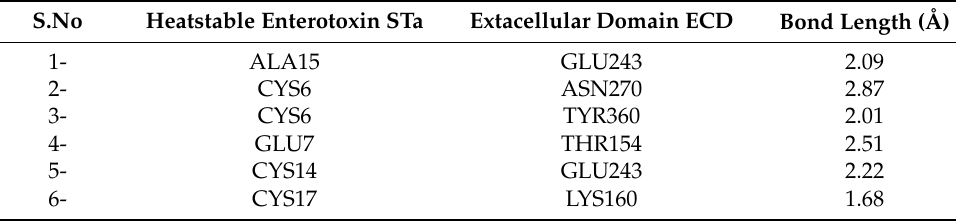
Figure 9. Model 0 of ECD GC-C and STa (PDB ID-1ETN) returned by ClusPro and visualized by Discovery Studio Visualizer. ECD is represented as ribbons. 1ETN is shown in tubular form. H-bonds are represented as dashed lines in a green color. Table 7. List of the amino acid residues forming hydrogen bonds in a protein–protein interface for ECD and Heat stable Enterotoxin STa (PDB